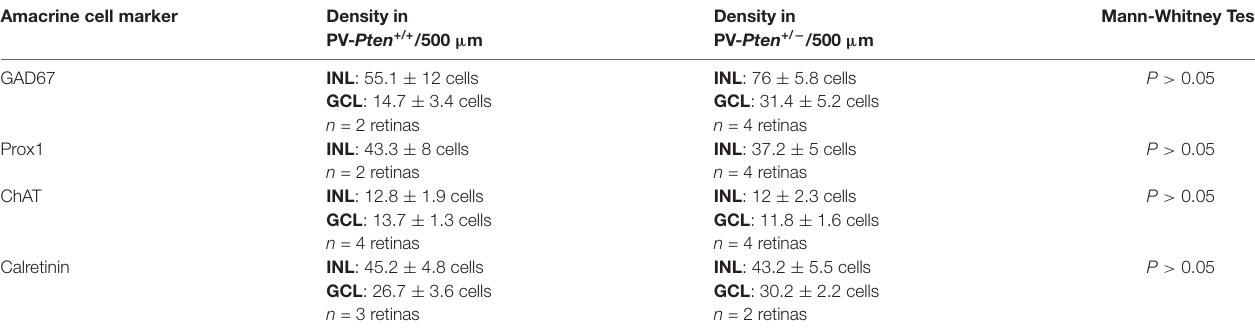
TABLE 2 | Amacrine cell populations in the PV- Pten mouse line.